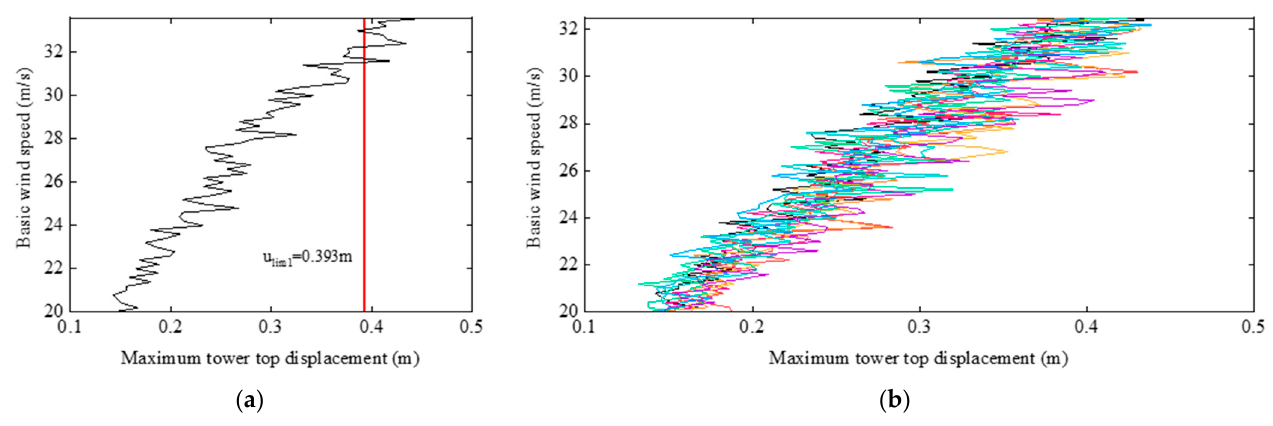
Figure 12. Variation curve of the maximum tower top displacement. ( a ) One of the incremental dynamic analysis results. ( b ) Multiple incremental dynamic analysis results. In the incremental dynamic analysis of the tower-line system, we considered that the basic wind speed corresponding to the tower top displacement that exceeded the critical displacement value for the first time was the basic collapse wind speed. The collapse wind speed for each sample was obtained and compared with that calculated using pushover analysis. As shown in Figure 13a, the collapse wind speed values obtained using the two methods were similar, with a maximum relative error of 5.7% and a mean relative error of 3.18%, indicating that the mass and coherence functions were considered when calcu- lating the equivalent wind load according to the load code for the design of the overhead transmission line [35]; therefore, accurate response results can be obtained using pushover analysis.